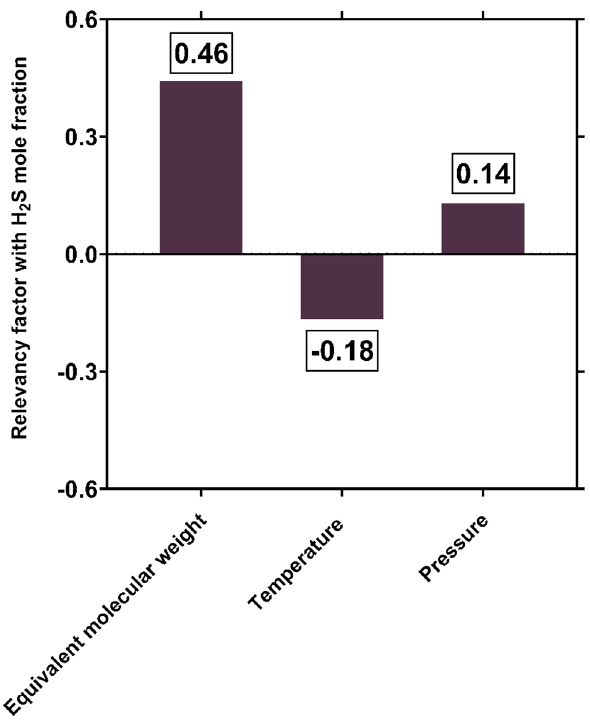
Figure 11. Relevancy factors between different input variables and the outcomes of GPR model for H 2 S solubility (created by GraphPad 8.4.3.686 145 ).